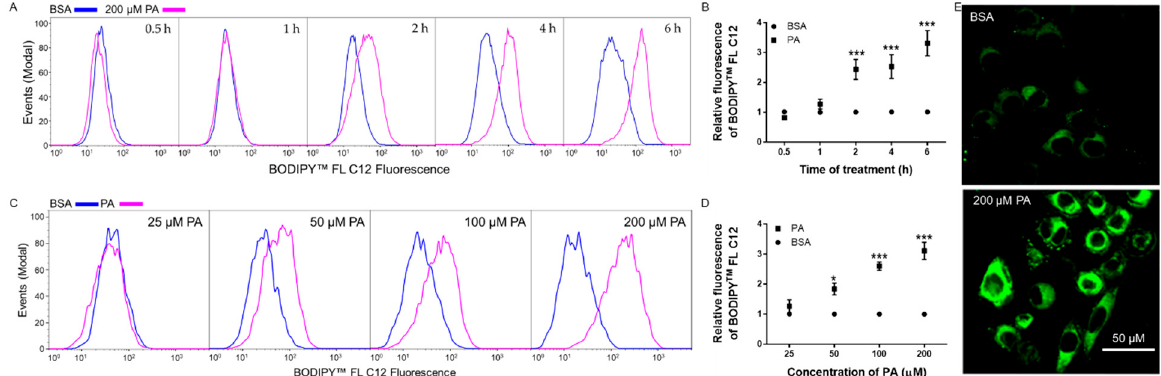
Figure 2. Time- and dose-dependent effects of PA treatment on BODIPY TM FL C12 uptake in N2a cells. ( A , B ) N2A cells were treated with 200 µ M PA or BSA for 0.5, 1, 2, 4, or 6 h, and then incubated with BODIPY TM FL C12 for 0.5 h. BODIPY TM FL C12 uptake was then measured by flow cytometry with representative histograms shown in ( A ) and quantitated data shown in ( B – D ) N2A cells were treated with different concentrations of PA or BSA control for 6 h, and BODIPY TM FL C12 uptake was then measured by flow cytometry with representative histograms shown in ( C ) and quantitated data shown in ( D , E ). BODIPY TM FL C12 fluorescence in N2a cells following 6 h treatment with BSA or 200 µ M PA visualized under confocal microscopy. Data presented were representative of three independent experiments. Data (Mean ± SEM) were analyzed using two-way ANOVA followed by Tukey’s multiple comparison test. * p < 0.05 vs. corresponding BSA control; *** p < 0.001 vs. corresponding BSA